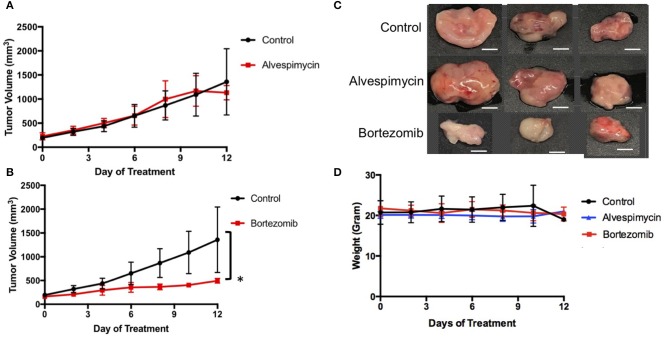
In vivo validation of top drug candidates reveals sensitivity of the LMS-D48 PDX to proteasome inhibition. (A) Alvespimycin (25 mg/kg) was administered intraperitoneally (i.p.) in vivo to SCID beige mice harboring LMS-D48 PDX tumors (n = 5 mice per treatment group) each in control and treatment groups. There was no statistical difference between control and treatment groups as measured by analysis of variance. (B) Bortezomib (1 mg/kg) was administered i.p. as described for alvespimycin above. Bortezomib significantly inhibited tumor growth of the PDX (p < 0.0001). (C) Representative images of resected tumors at treatment endpoint from the treatment and control groups show that control tumors are approximately twice the size of bortezomib-treated tumors (scale bar = 0.5 cm). (D) Animal weights were not significantly changed during treatment with either alvespimycin or bortezomib during the treatment course.